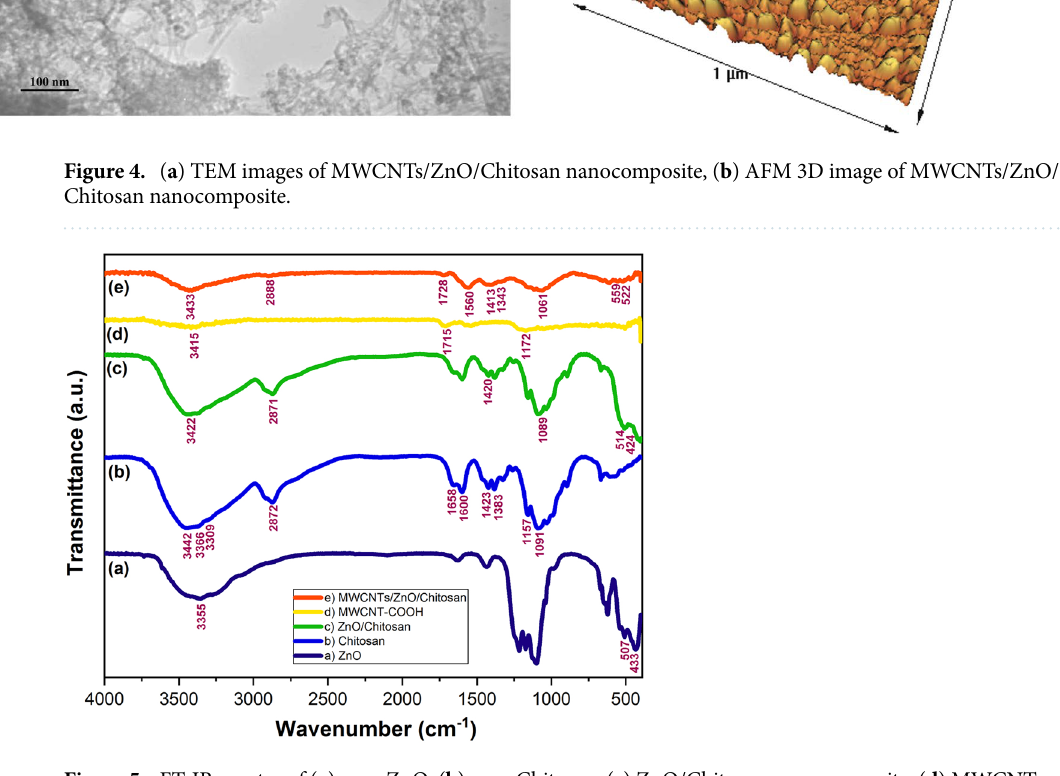
Figure 5. FT-IR spectra of ( a ) pure ZnO, ( b ) pure Chitosan, ( c ) ZnO/Chitosan nanocomposite, ( d ) MWCNT- COOH and ( e ) MWCNTs/ZnO/Chitosan